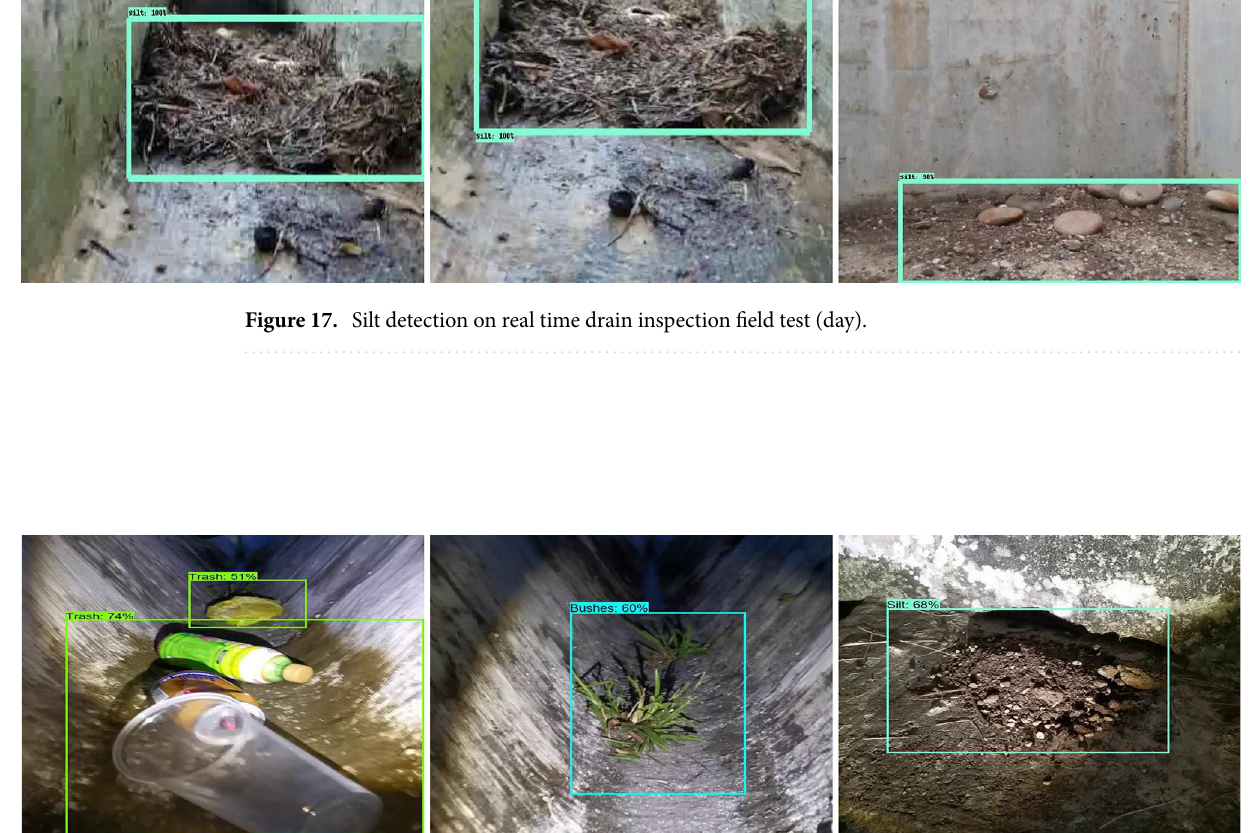
Figure 18. Real time drain inspection field test